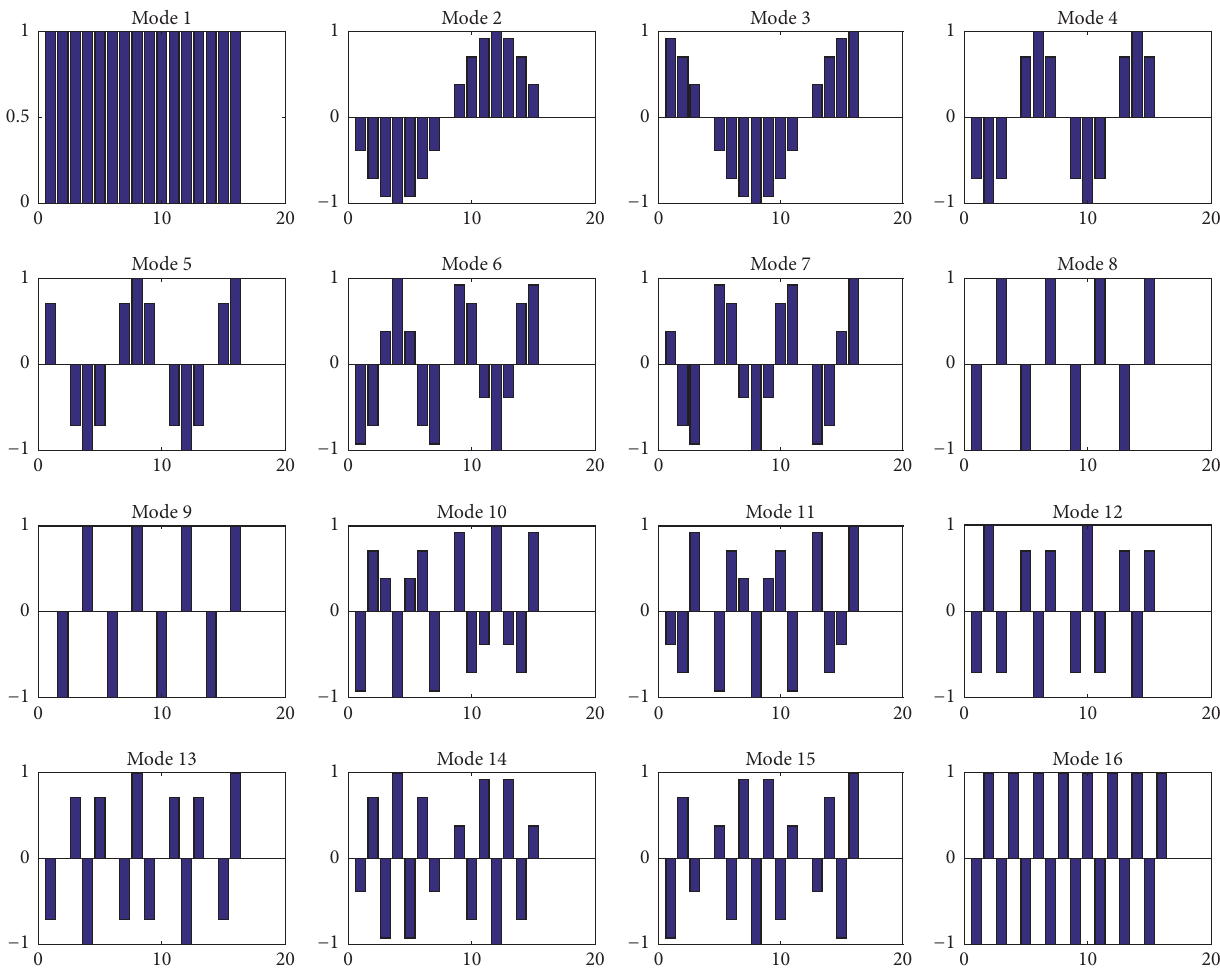
Figure 4: Natural shapes of tuned rotated blades under different